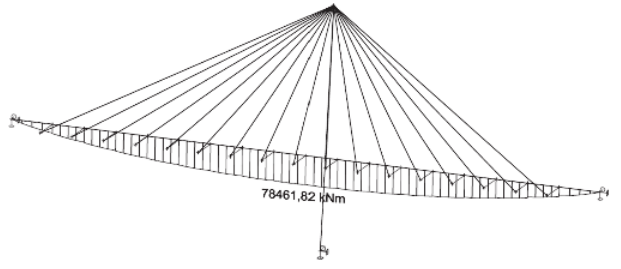
Figure 27 Bending moment on straight deck (P+L): external case